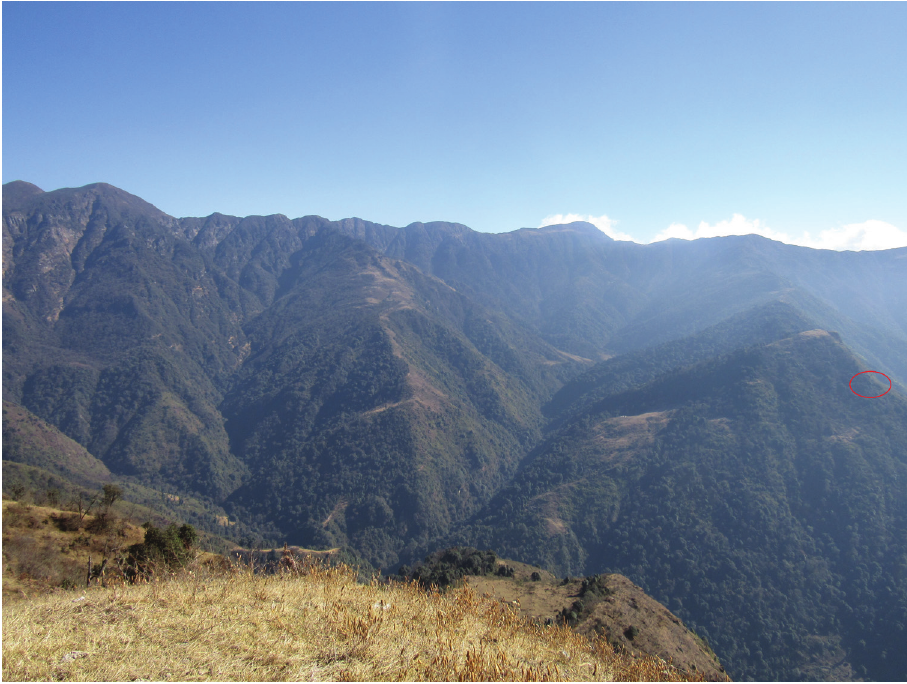
Figure 3. The landscape and forests of the marbled cat capture area in Iwaa valley. The cat was photo- graphed at far right (marked with red oval). (Sonam Tashi Lama-Lincoln University/Red Panda